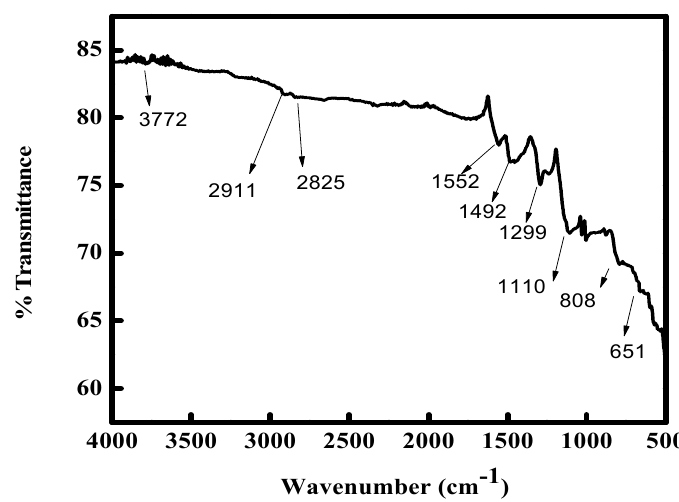
Figure 2. Fourier-transform infrared spectroscopy (FTIR) spectrum of the synthesized PANI.